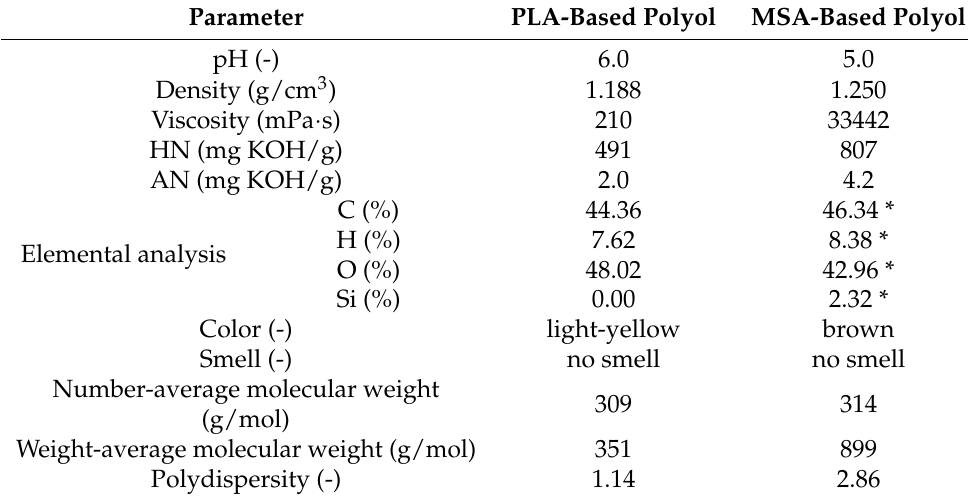
Table 1. Properties of synthesized